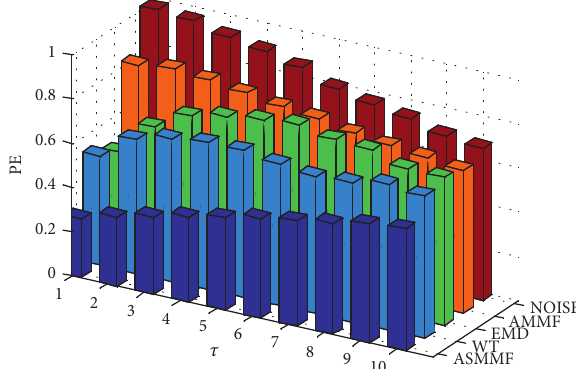
Figure 12: The MPE of denoising results.